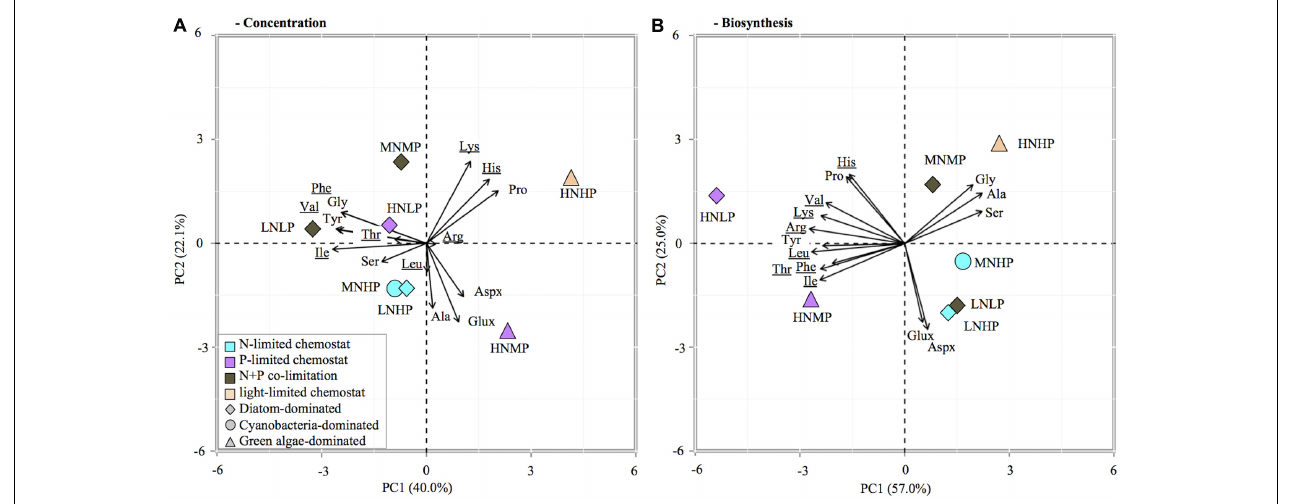
FIGURE 4 | Principle component analysis (PCA) biplot of relative contribution of individual AA to total AA concentration in POC (A) and total AA synthesis (B) . Symbol color indicates limitation, symbol shape refers to dominant phytoplankton group. The analysis included 15 amino acids: glutamate/glutamine (Glux), aspartate/asparagine (Aspx), threonine (Thr), valine (Val), isoleucine (Ile), leucine (Leu), lysine (Lys), histidine (His), phenylalanine (Phe), argin (Arg), serine (Ser), glycine (Gly), alanine (Ala), proline (Pro), and tyrosine